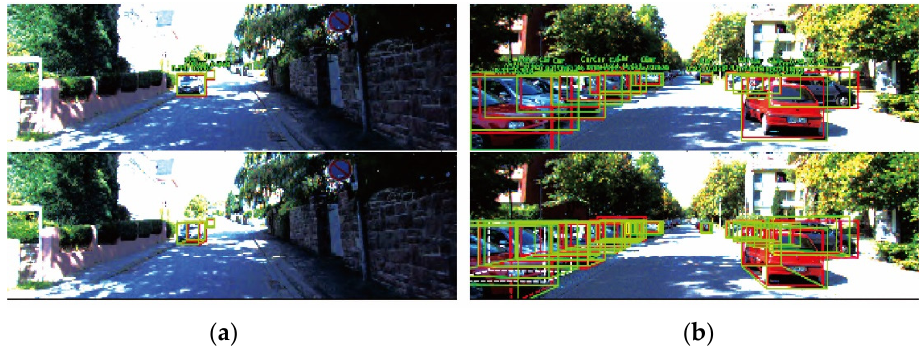
Figure 13. Multitarget scene experiment results: ( a ) long-range vehicles; and ( b ) blocking of vehicles.